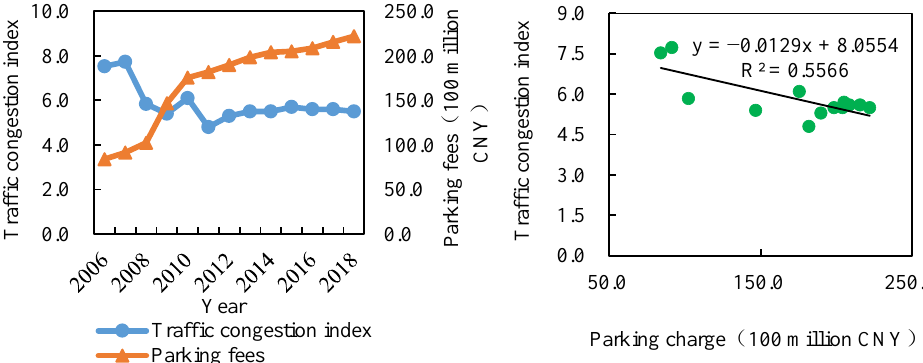
Figure 3. The relation between parking fees and the traffic congestion index in Beijing.